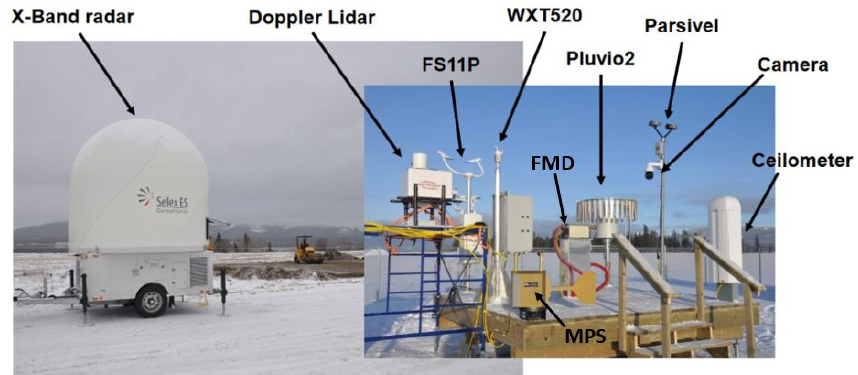
Figure 5. The Whitehorse supersite instrument platform and X-band radar ( ∼ 10m away) as viewed on 12 December 2017. Images were taken facing NE, with the CYXY Whitehorse airport runway behind the photographer. All instruments are labelled.